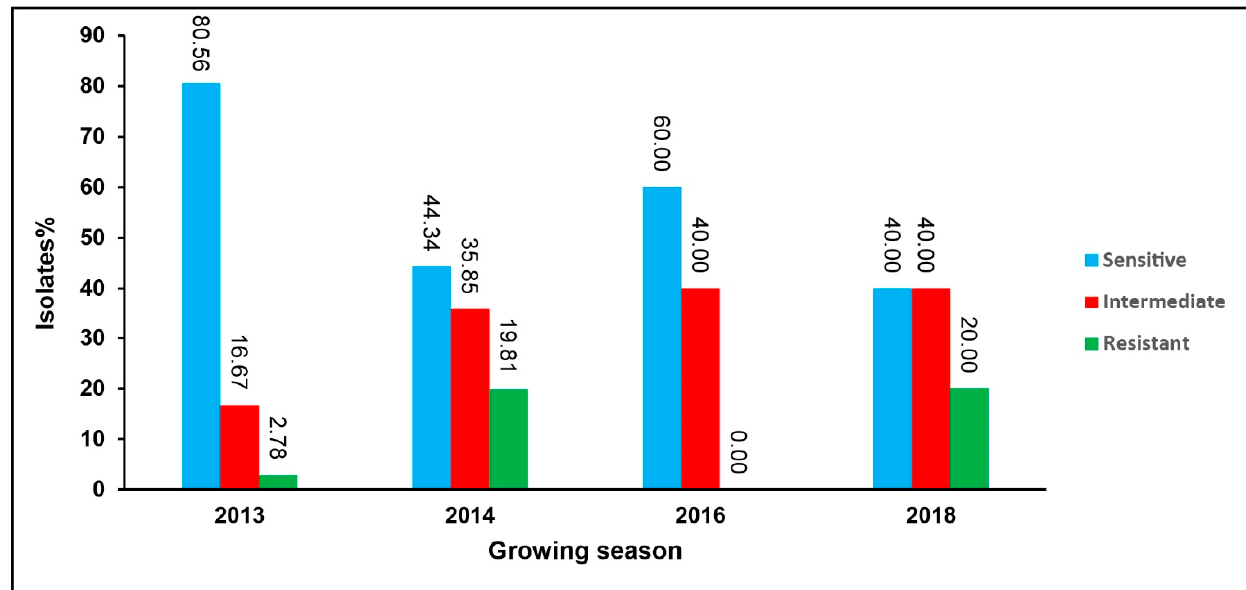
Figure 2. Late blight lesion on tomato plant showing white sporulation on the abaxial side of in- fected leaves ( A ), sporulated lesions on potato leaves ( B ), late blight symptoms on eggplant leaves ( C ), a close-up image of sporulating lesions and sporangia ( D ), microscopic view of semi-papillate sporangia ( E ), oospore inside an oogonium attached with an amphigynous antheridium ( F ). Scale bar 10 µm.